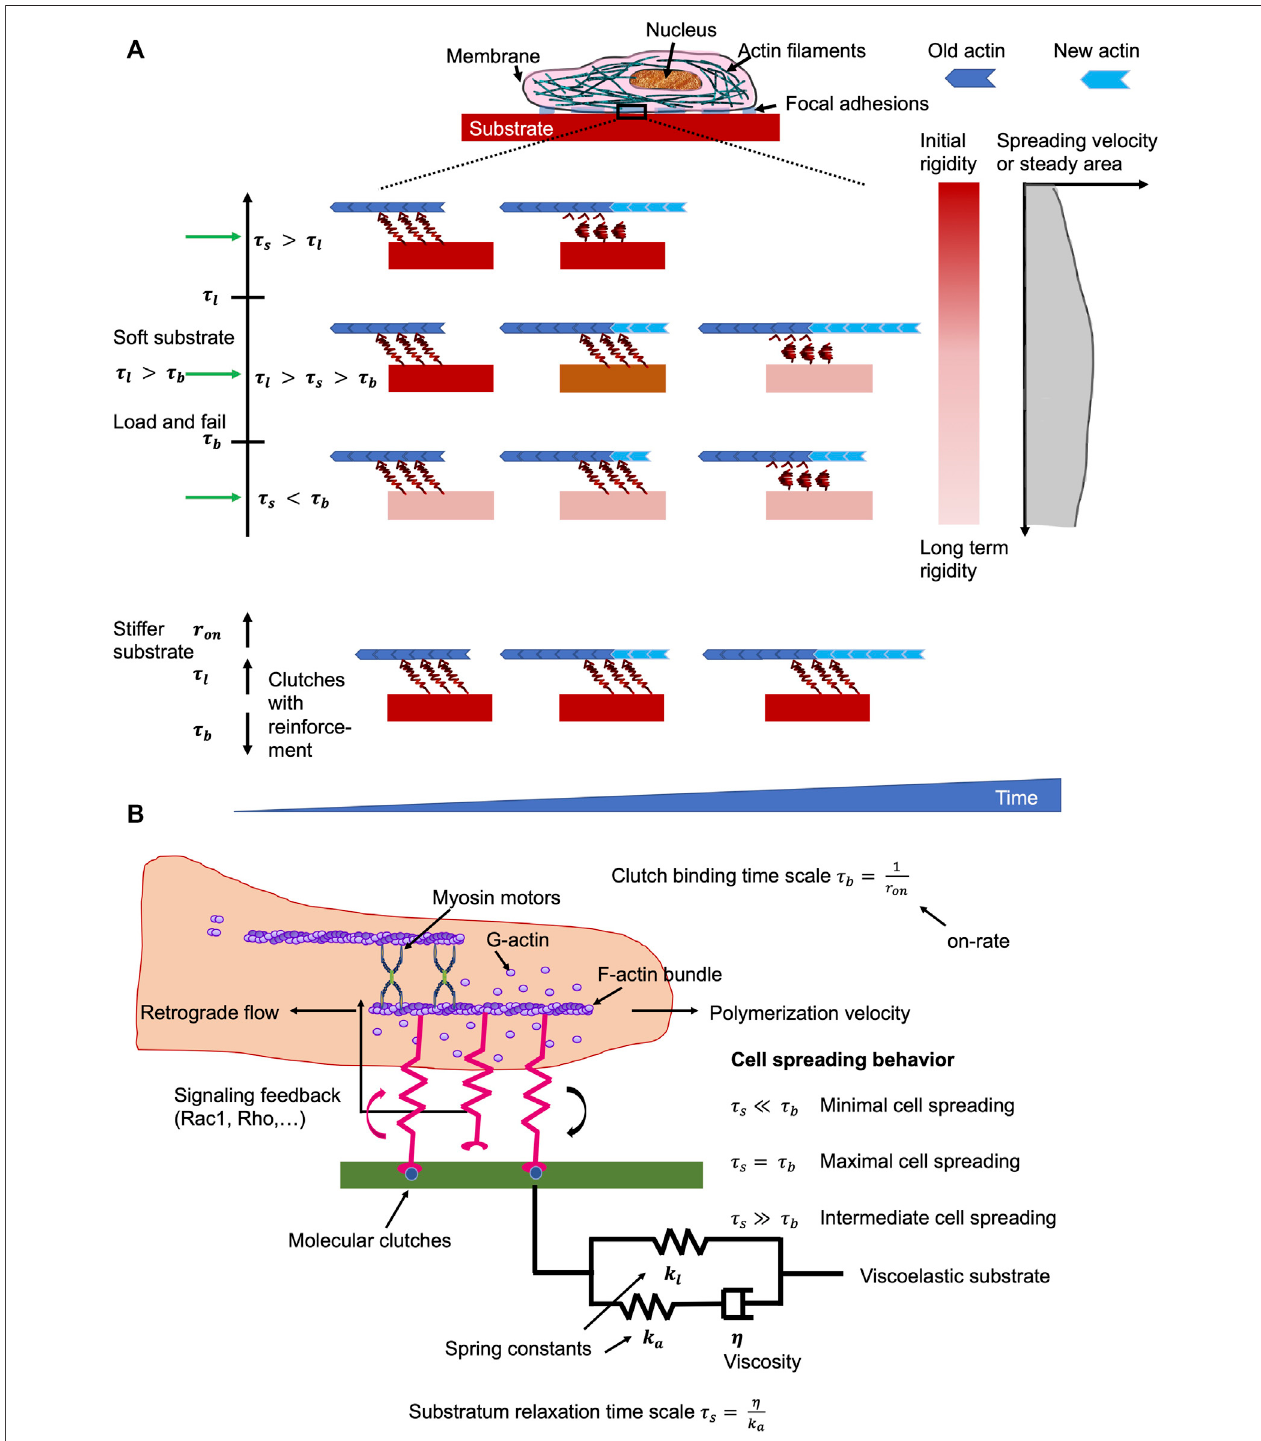
FIGURE 5 | Matrix environments impacts cell mechanics. The ideal viscosity minimizes the retrograde fl ow of actin whereby the turnover of focal adhesions is prolonged on soft materials. (A) Effects if the substrate viscoelasticity toward the characteristics of cells in relation to clutch binding, τ b , substrate relaxation, τ s , and cellular life timescales τ l . In the load and fail domain with τ l > τ b , the spreading of cells is maximal when τ l > τ s > τ b . It means that the cells sense a surrounding material with high initial stiffness, which vastly relaxes after the clutch engagement. However, when the viscosity of the material is low, such as τ s < τ b , cells can merely perceive long-term rigidity that elevates the lifetime of focal adhesions, but did not impair the retrograde fl ow of actin. When the viscosity of the substrate is relatively elevated, such as τ s > τ l , the cells perceive solely the starting rigidity, which did not alter the lifetime of focal adhesions, but lead to premature clutches that cannot ful fi ll